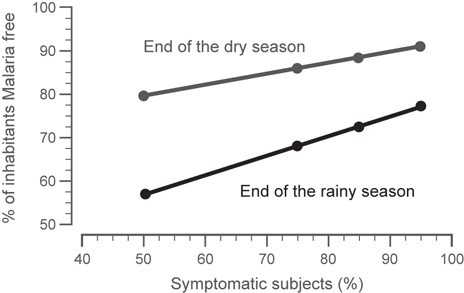
Influence of the percentage of symptomatic subjects who have malaria on the underlying disease levels. As more subjects are symptomatic, more are able to be treated resulting in less patients with malaria at the end of either the dry or rainy season.